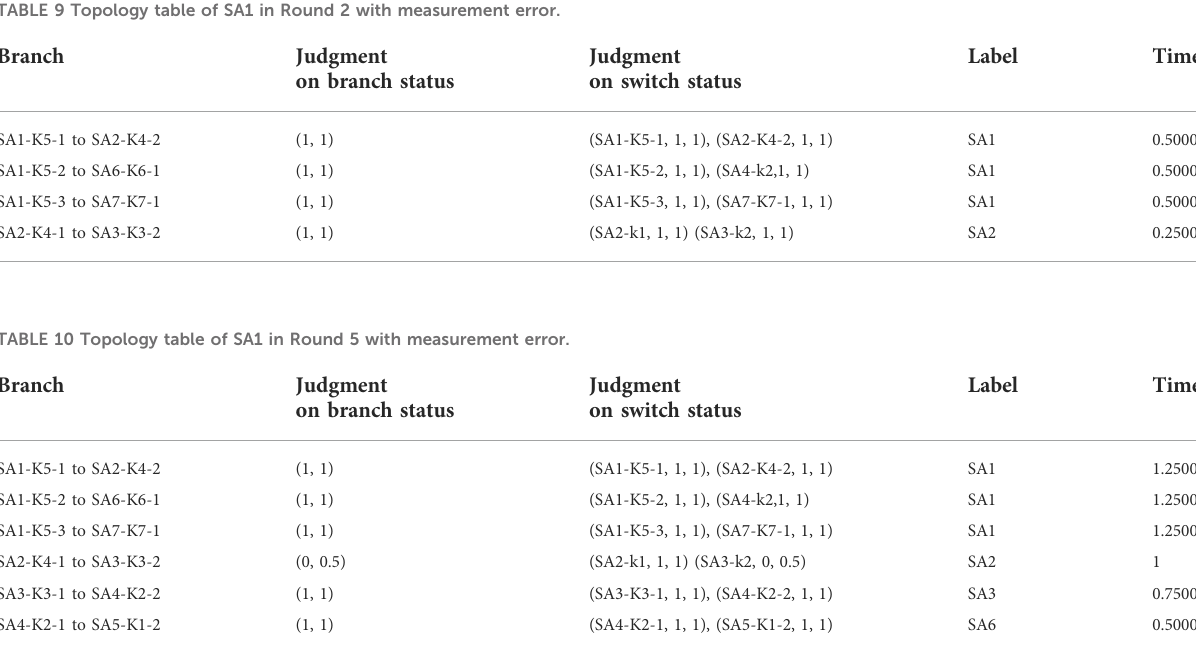
TABLE 9 Topology table of SA1 in Round 2 with measurement error.